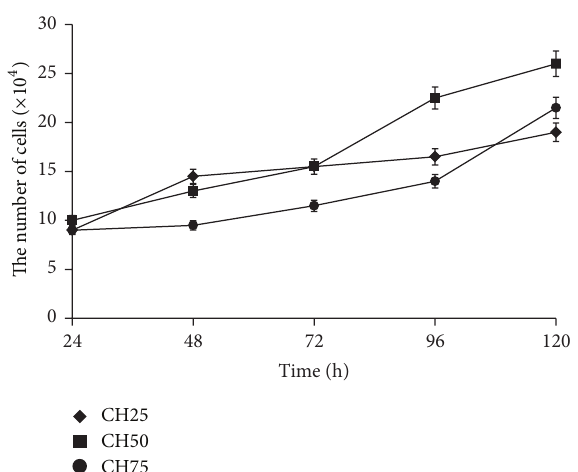
Figure 7: Cell proliferation of NIH3T3 fibroblasts cell on various grafted PVA-g-chitosan 3D scaffolds as a function of time.